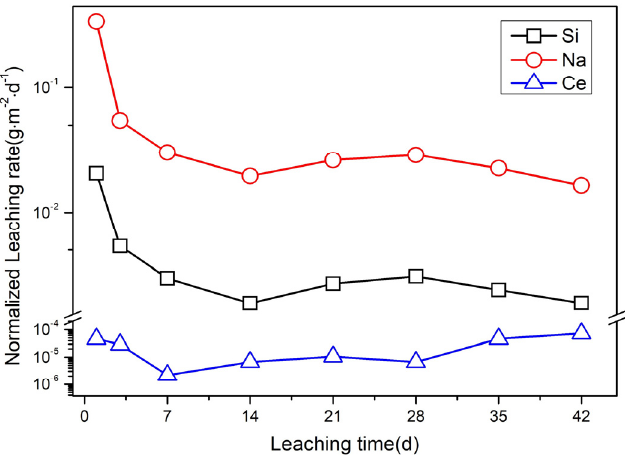
Figure 7. Normalized leaching rates of Si, Na, and Ce from day 1–42.